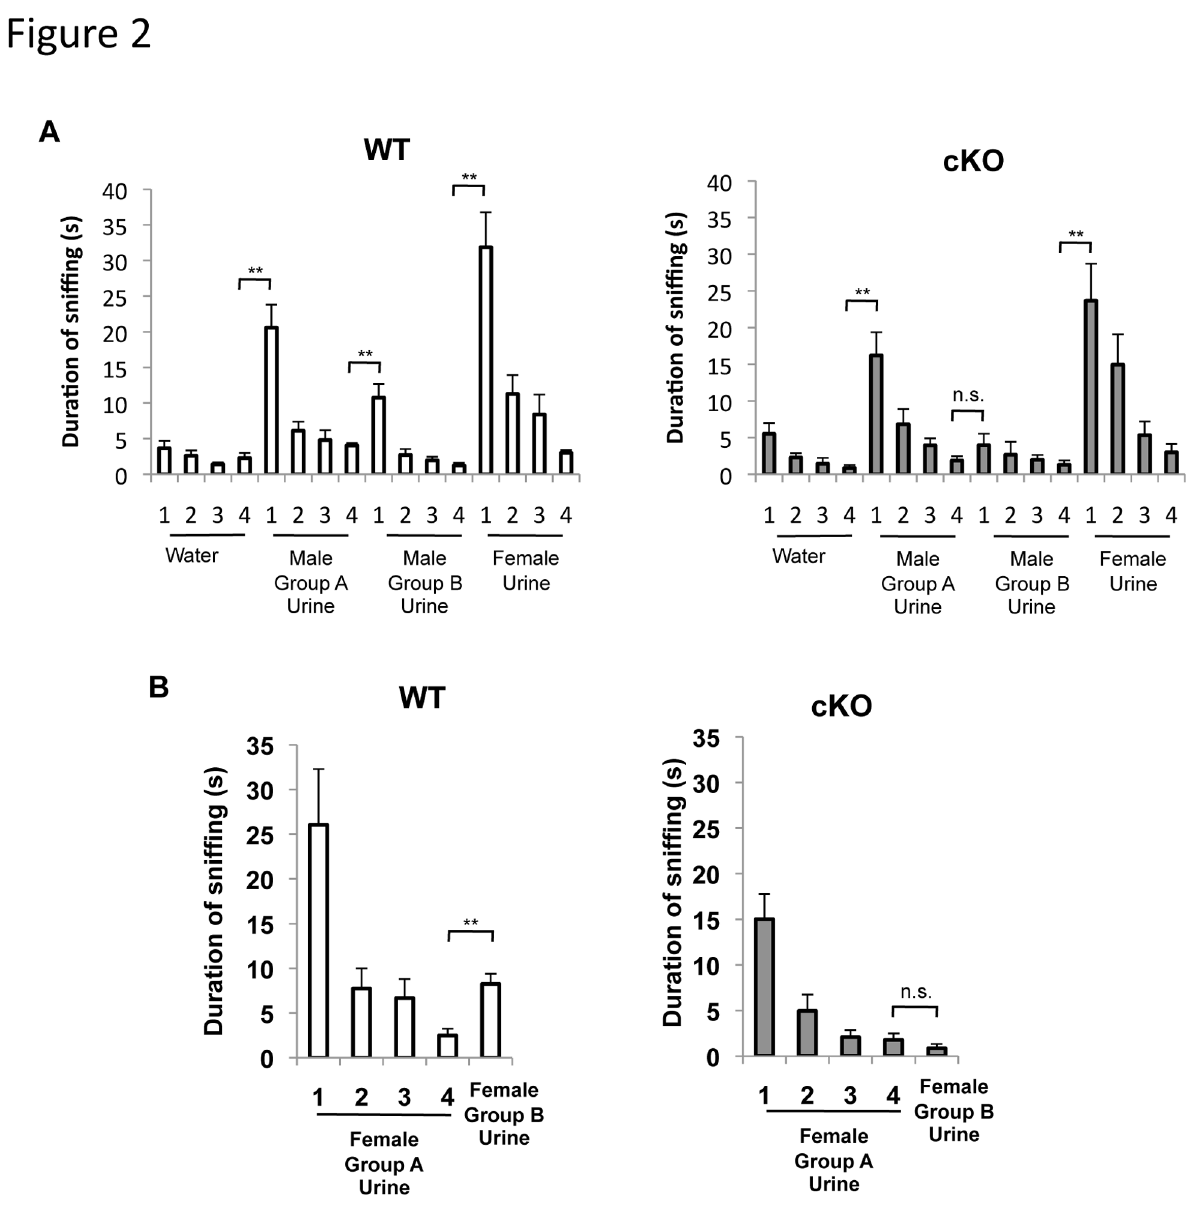
Figure 2. ERK5 cKO mice are deficient in discriminating urine samples from different groups of mice of the same gender. A , ERK5 cKO mice are able to sense and discriminate between male and female urine but cannot discriminate urine samples from different groups of male mice in a standard habituation/dishabituation olfaction test. Naïve, adult mice were pre- trained with four presentations of water-soaked cotton swabs, then exposed sequentially to three urine samples collected from two groups of 10 male mice (Male Group A and B) and one group of 10 female mice. B , Similarly, ERK5 cKO mice cannot distinguish between urine samples from Group A and B female mice. n.s., not significant; **, p<0.01.